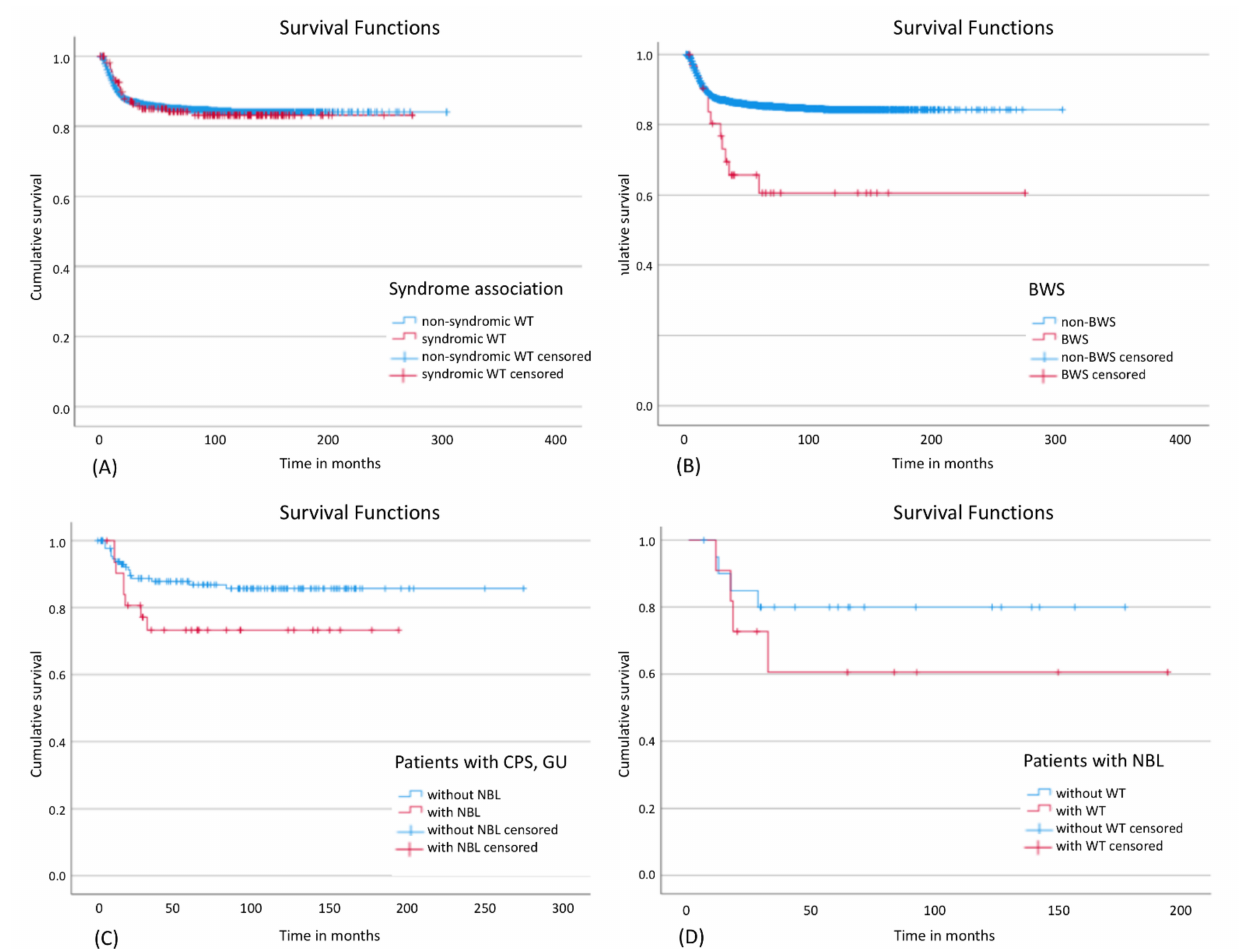
Figure 3. Event-free survival in different subgroups: ( A ) Influence of a syndrome on EFS in patients with WT and/or nephroblastomatosis; Log Rank: p = 0.890; ( B ) Influence of BWS on EFS in patients with WT and/or nephroblastomatosis; Log Rank: p = 0.002; ( C ) Influence of nephroblastomatosis on EFS in patients with a CPS; Log Rank: p = 0.086; ( D ) Influence of WT on EFS in patients with nephroblastomatosis; Log Rank: p = 0.315. CPS: cancer predisposition syndrome; BWS: Beckwith-Wiedemann spectrum; NBL: nephroblastomatosis, GU: Genitourinary